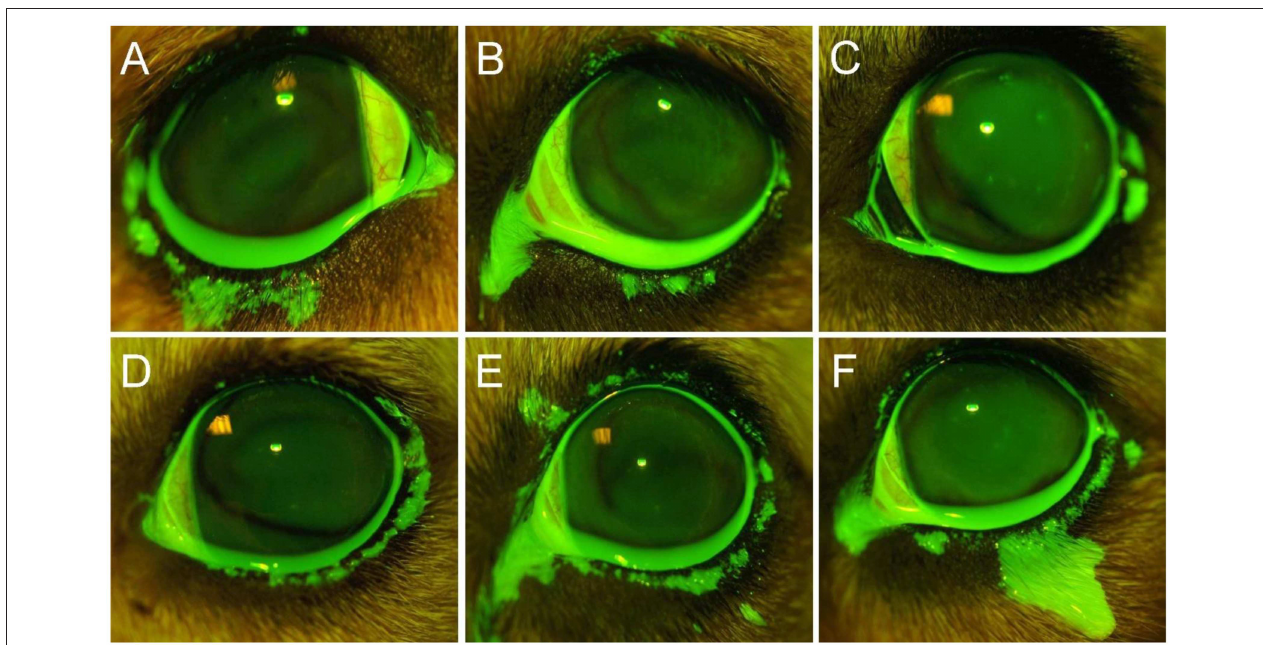
FIGURE 4 | Representative ocular images following instillation of 60 µ l (A) , 80 µ l (B) , 40 µ l (C) , or 100 µ l (D–F) of 0.1% fluorescein solution in different Beagle dogs. Notice the periocular spillage that predominantly affects the lower eyelid (A) , medial canthus (B) , lateral canthus (C) , or multiple locations including the upper eyelid (D–F) .